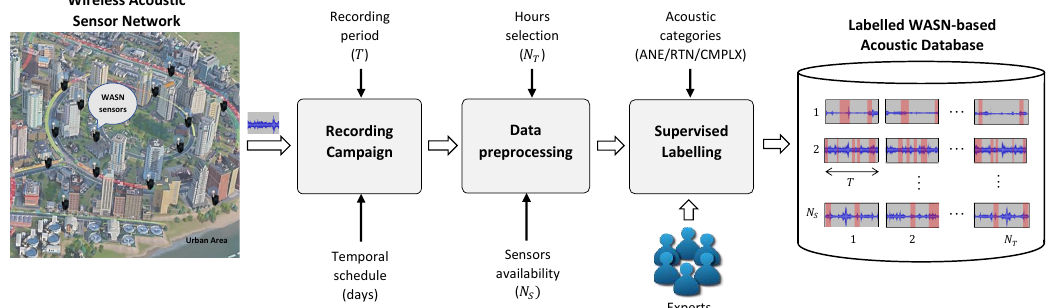
Figure 1. Block diagram of the generation process to develop a labelled Wireless Acoustic Sensor Network (WASN)-based acoustic database, where the labels are Anomalous Noise Event (ANE), Road Traffic Noise (RTN) and complex (CMPLX), denoting the latter complex audio